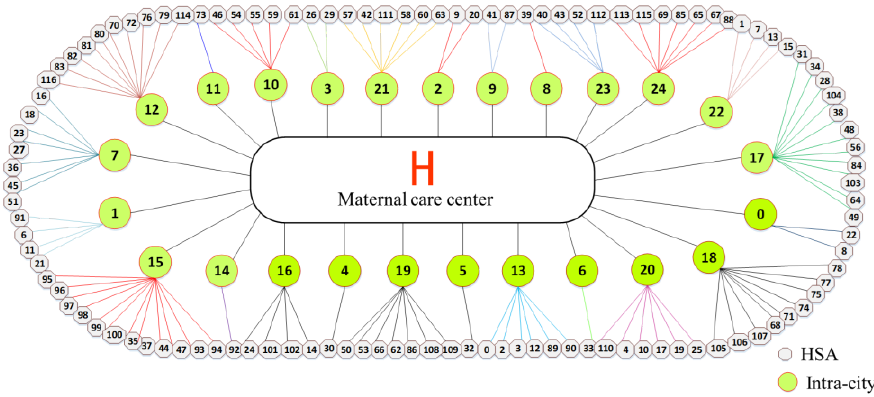
Figure 11. Spatial distribution map of three-tier referral system.